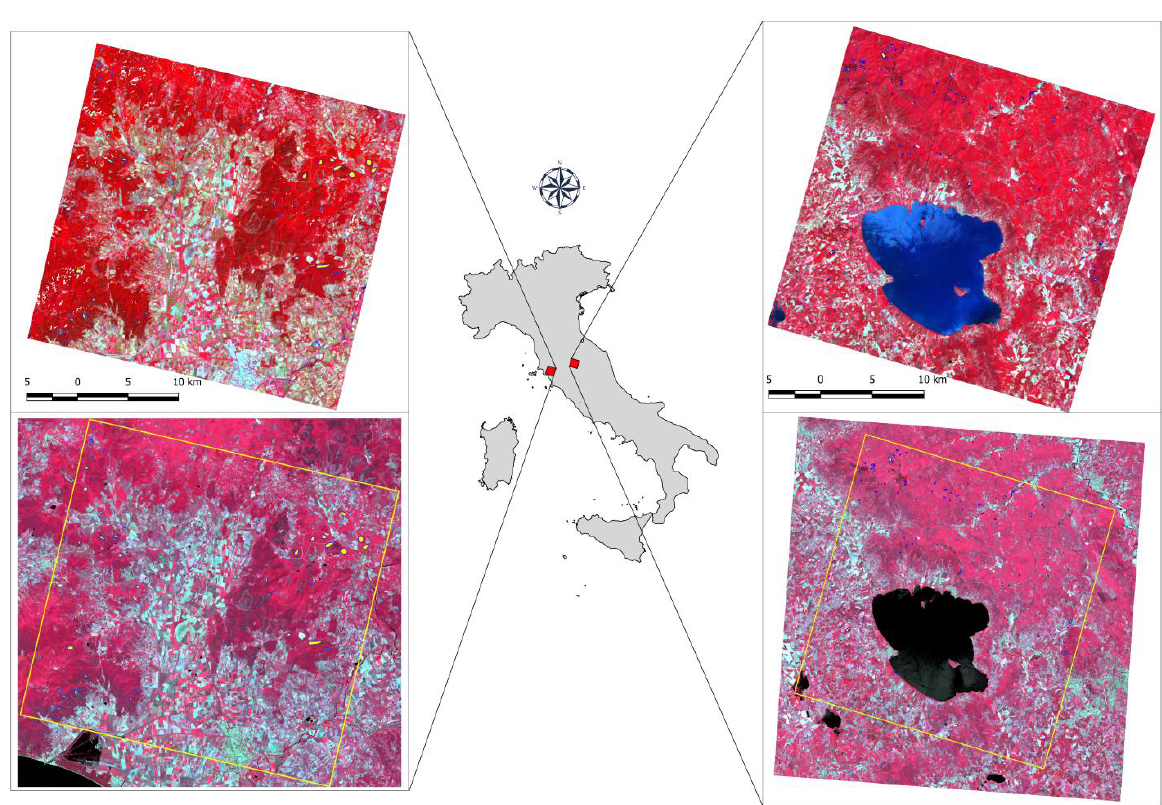
Figure 2. The two study areas. On top: PRISMA false color (RGB 66-35-17); on bottom: Sentinel-2A false color (RGB 8-4-3). In yellow: the boundaries of the PRISMA scene in the Sentinel one.